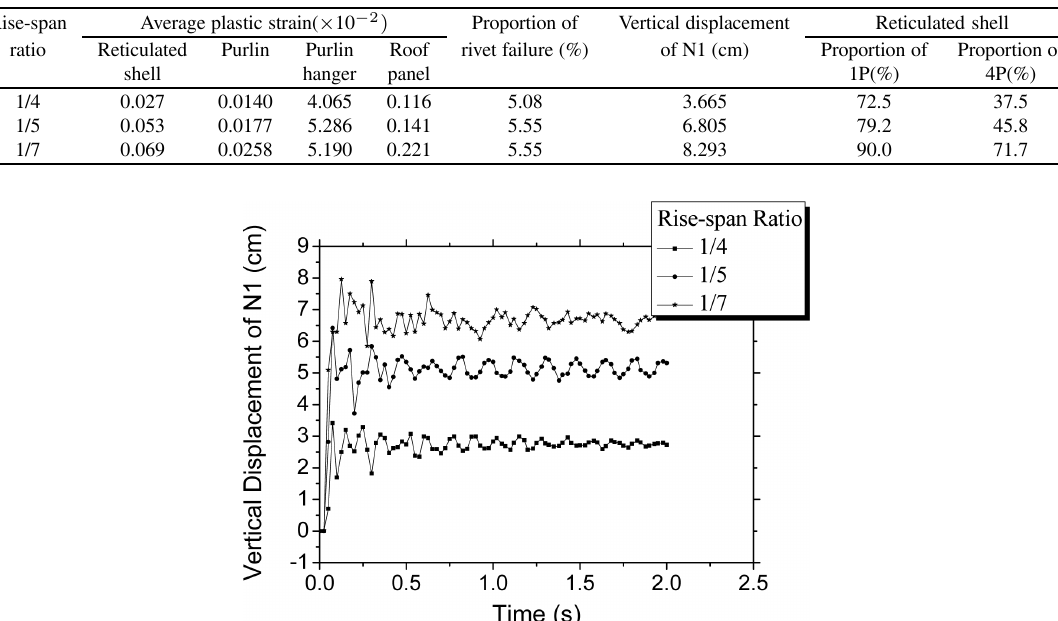
Table 5 Response characteristics of structure with different rise-span ratio (TNT is 104 kg)